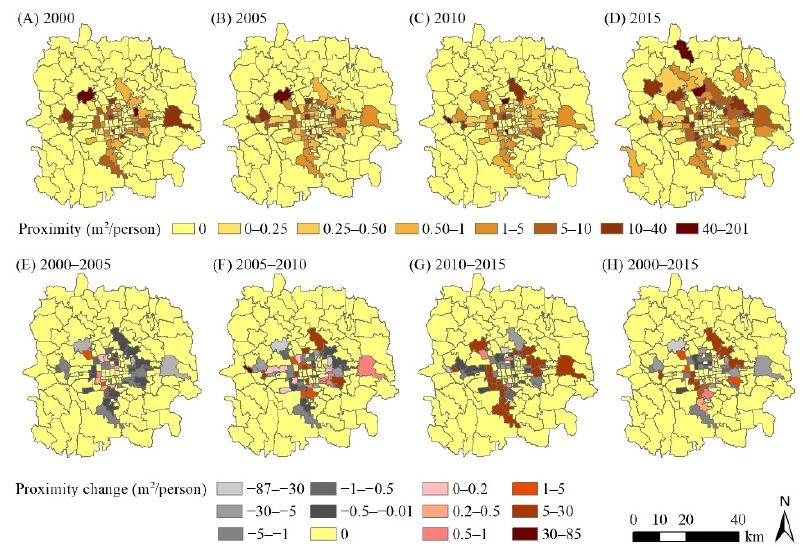
Figure 4. Distribution and changes of accessibility of 2 km catchment. ( A – D ) represent the distribu- tion pattern of urban park proximity of 2 km catchment in 2000, 2005, 2010 and 2015, respectively; ( E – H ) represent the change of urban park proximity of 2 km catchment from 2000–2005, 2005–2010, 2010–2015 and 2000–2015, respectively.